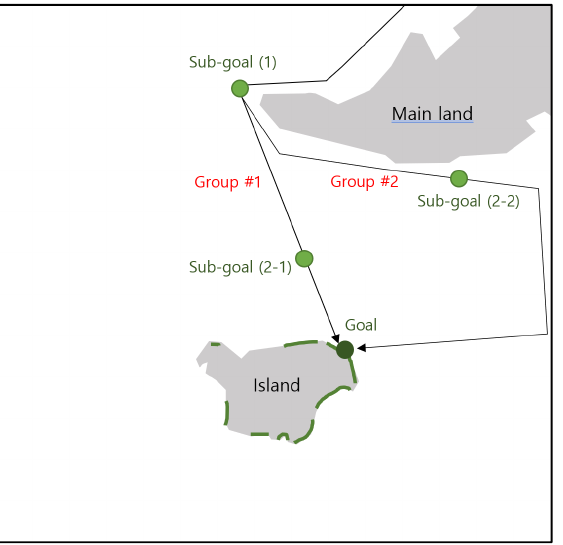
Figure 5. Information on the case designated for the experiment.